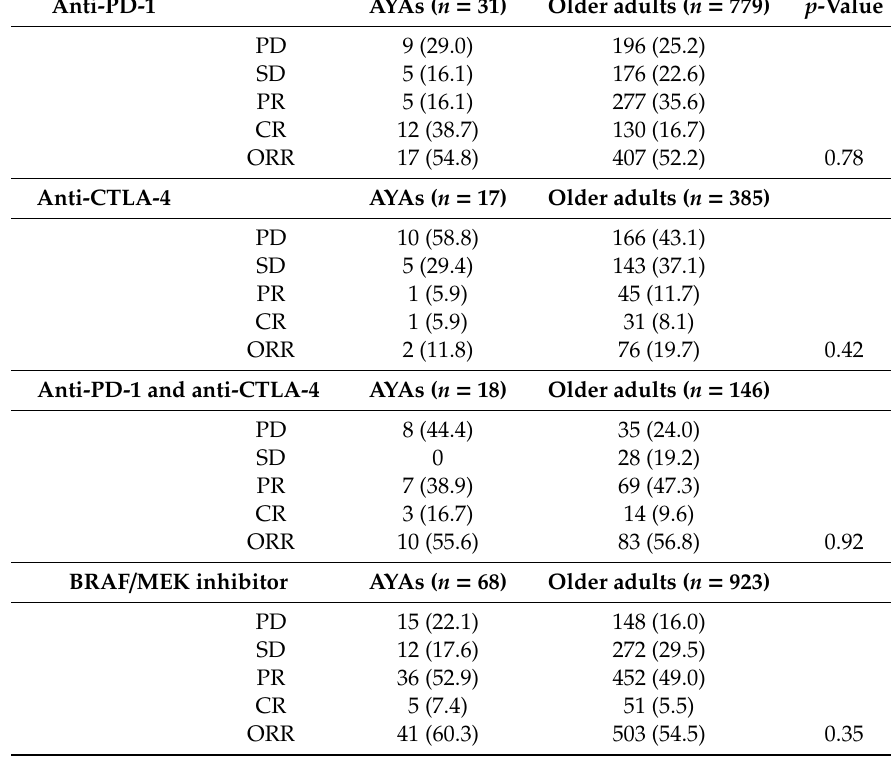
Table 2. Best overall response and objective response rate following systemic treatment in Adolescents and Young Adults (AYAs) and older adults. Best overall response (BOR) was classified as either; progressive disease (PD), stable disease (SD), partial response (PR) or complete response (CR). Objective response rate (ORR) was the combination of PR and